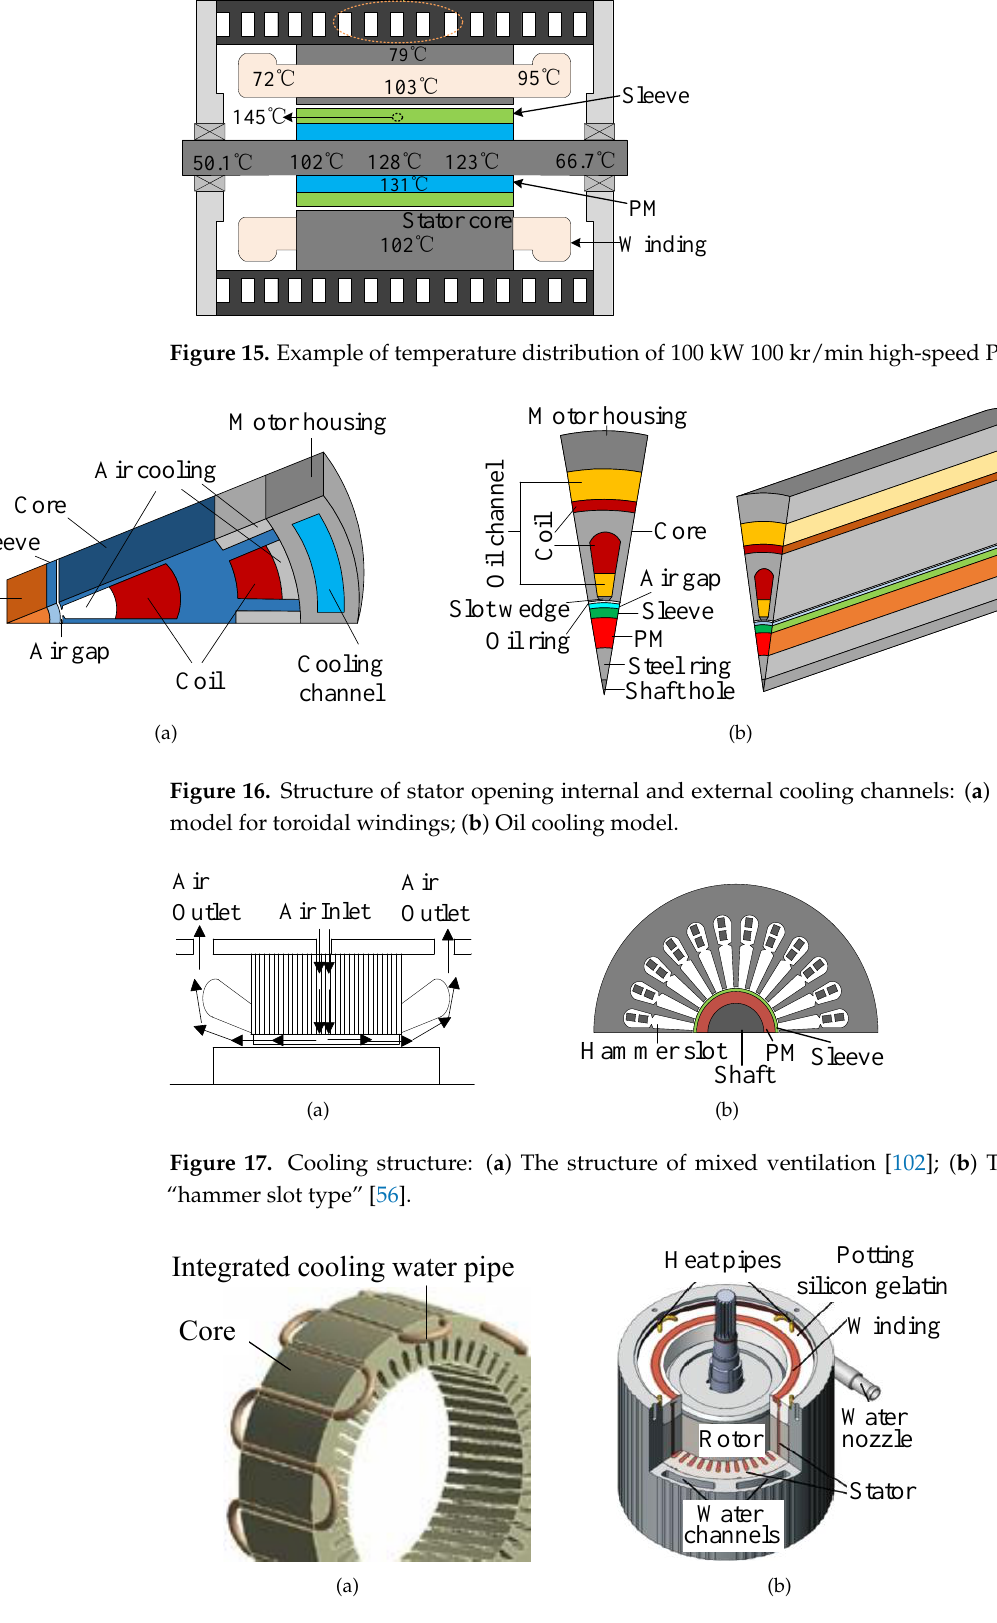
Figure 18. Motor cooling solution with additional heat path enhancement: ( a ) Stator integrated water pipe [108]; ( b ) Heat pipe and thermal adhesive to enhance heat dissipation